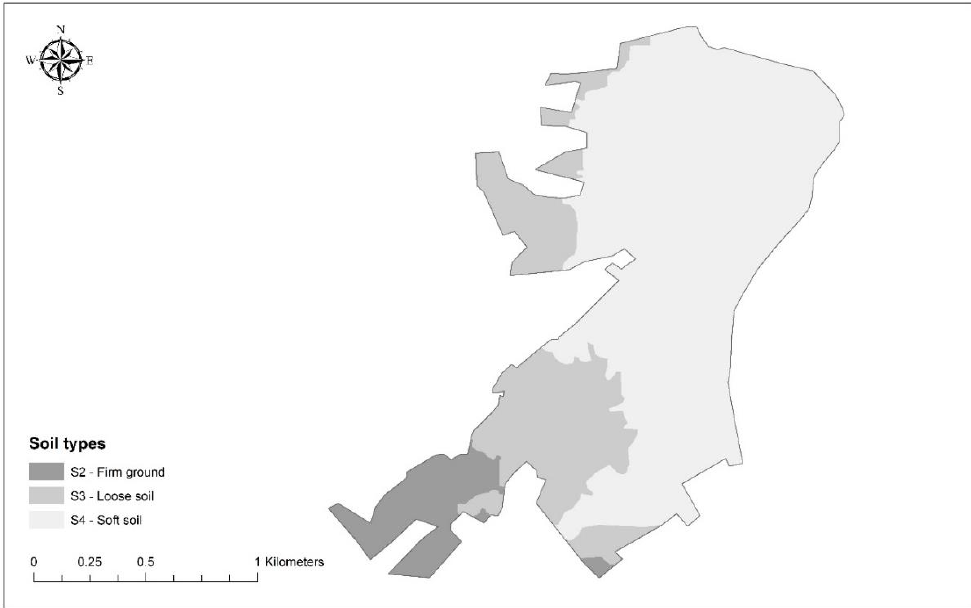
Figure 5. Distribution of soil types in the city of Imzouren [56].